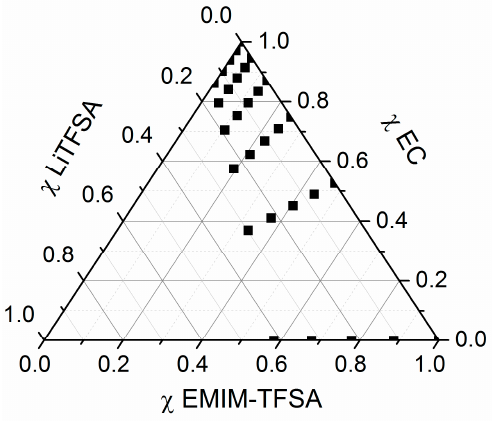
Figure 2. Visualization of the mixtures in ternary mole fraction diagram.